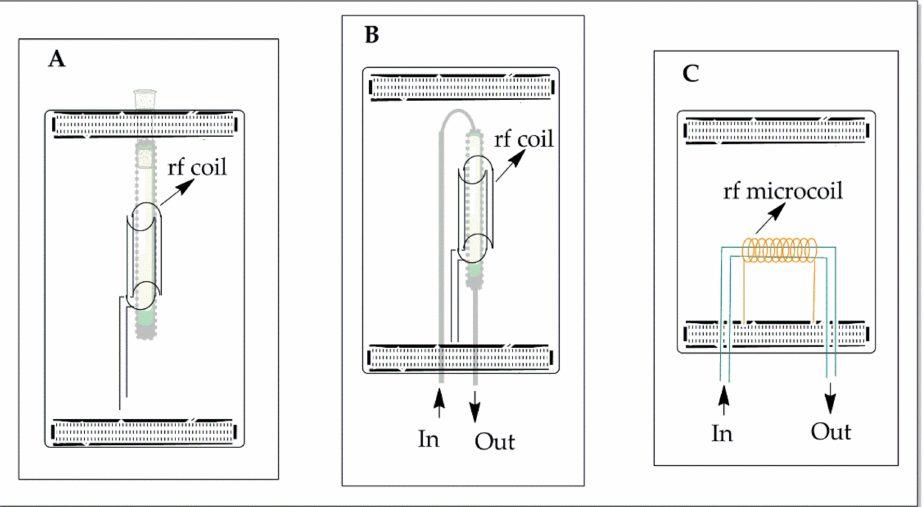
Figure 7. Schematics of NMR cryoprobes: ( A ) conventional and ( B ) saddle/U-shaped continuous- flow NMR probes and ( C ) solenoidal design called Microprobe with